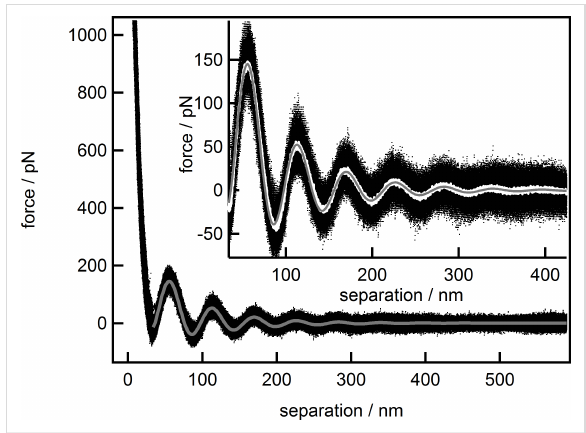
Figure 5: Combined force data of the 9 wt % suspension (black dots) together with the fit based on Equation 2 made from 34–600 nm (solid gray line). The inset displays the binominal smooth (solid white line, 10 3 data points) of the data.